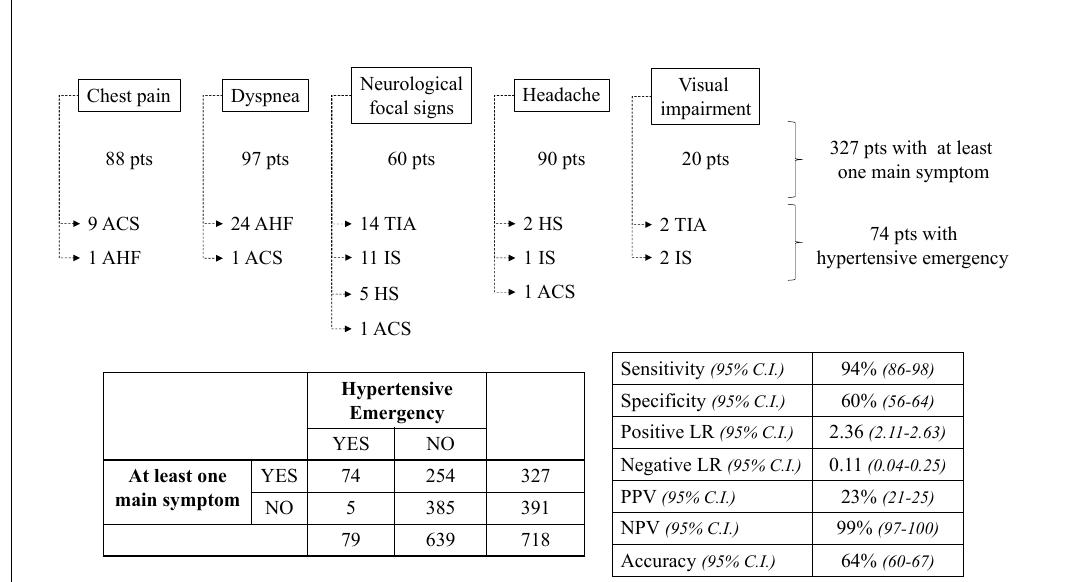
Figure 2. Accuracy of the symptoms-based diagnostic strategy as screening assessment. ACS: acute coronary syndrome; AHF: acute heart failure; TIA: transient ischemic attack; IS: ischemic stroke; HS: hemorrhagic stroke; pts: patients; LR: likelihood ratio; PPV: positive predictive value; NPV: negative predictive value.